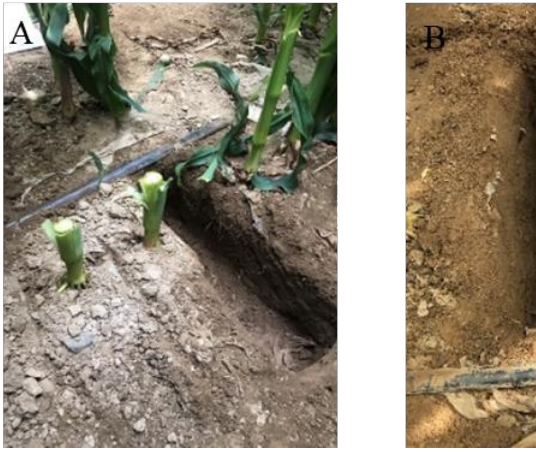
Figure 3. Maize roots were collected in the field. This method will be adopted in both Qitai and Yinchuan in 2018 and 2019. ( A ) Plant selection and shoot cutting; ( B ) Excavating fixed soil layer by layer; ( C ) Root system